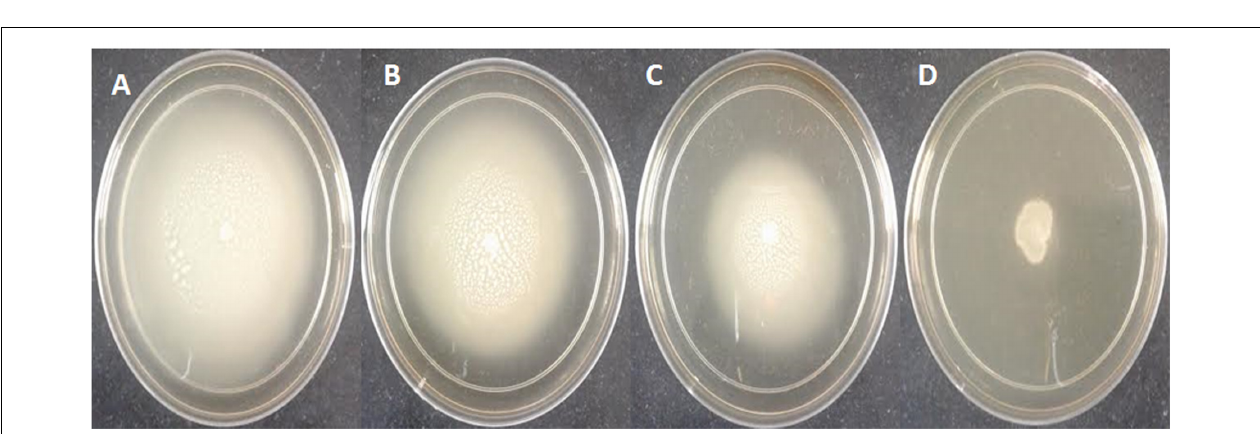
FIGURE 2 | Scanning electron microscopic (SEM) images for inhibition of biofilm of Pseudomonas aeruginosa PA01 at Sub minimum inhibitory concentrations. Images shown the effect on biofilm formation at 400 µ g/ml (B) and 800 µ g/ml (C) concentration of Mangifera indica (methanol) extract compared to control (A) .